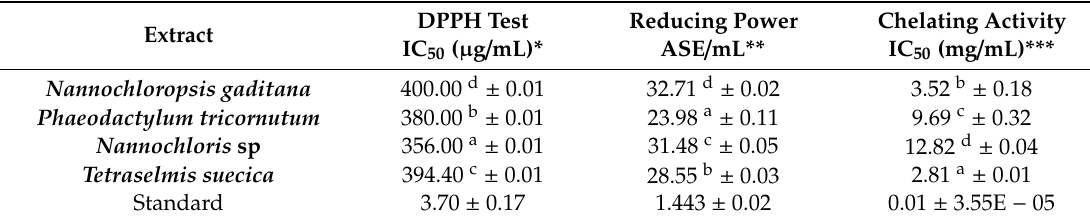
Table 2. Results of the antioxidant tests. DPPH test ( µ g / mL). Reducing power (ASE / mL). Chelating activity (mg / mL).